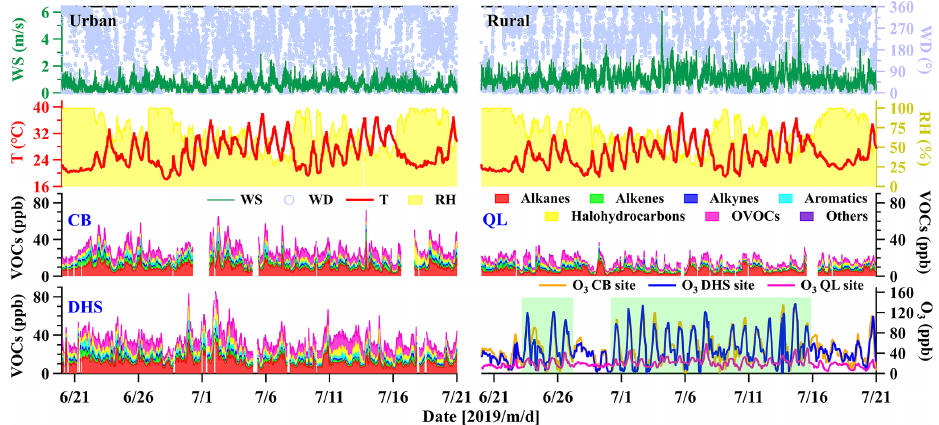
Figure 2. Time series of wind speed (WS), wind direction (WD), temperature ( T ), relative humidity (RH), O 3 , and VOCs at the CB, DHS, and QL sites. The green area in the figure represents periods with O 3 levels exceeding the Chinese national standard at the CB and DHS sites. Time is expressed in China CST.